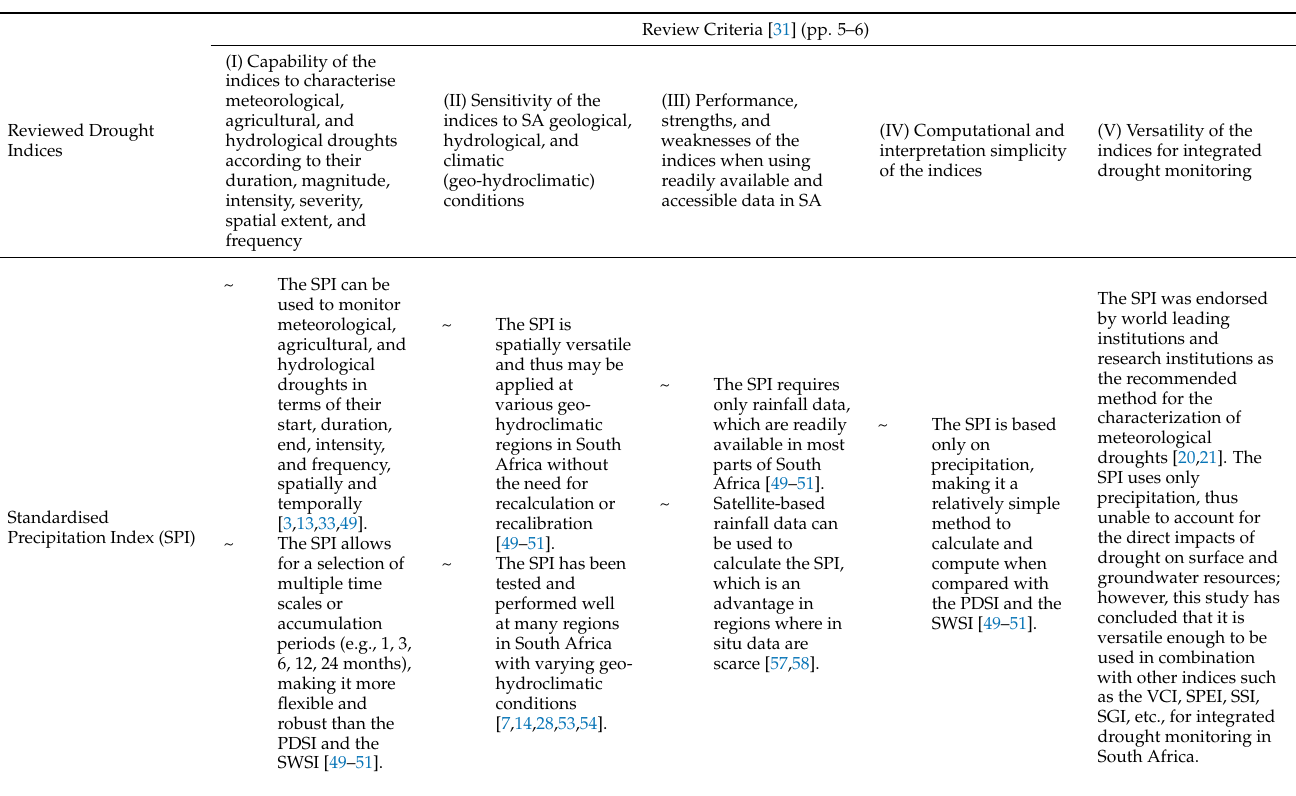
Table 3. Review of the SPI; based on the 2016 WMO Handbook of Drought Indicators and Indices [31] (pp.